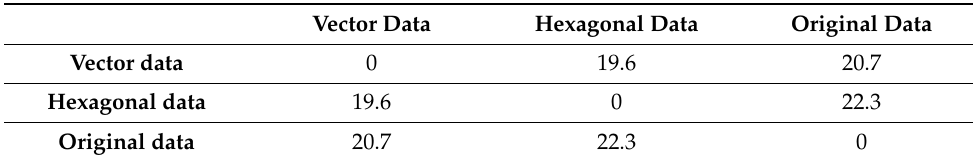
Figure 15. Comparison of linear feature extraction results among the original Landsat 8 hexagonal image and vector data. Table 8. Error band of different data resources.